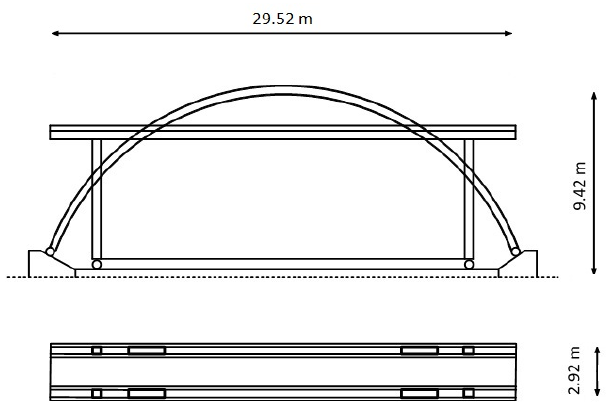
Figure 1. Geometric characteristics of the Kanellopoulos timber bridge (Patras, Greece). Top: side view, bottom: plan view.